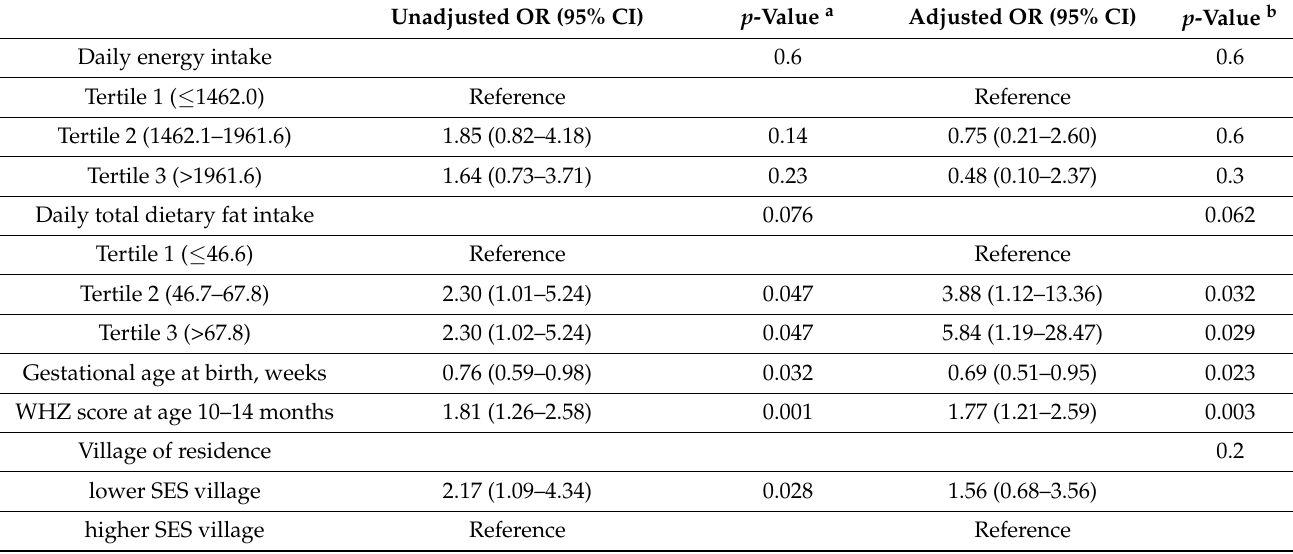
Table 4. Correlates of obesity among children aged 10–12